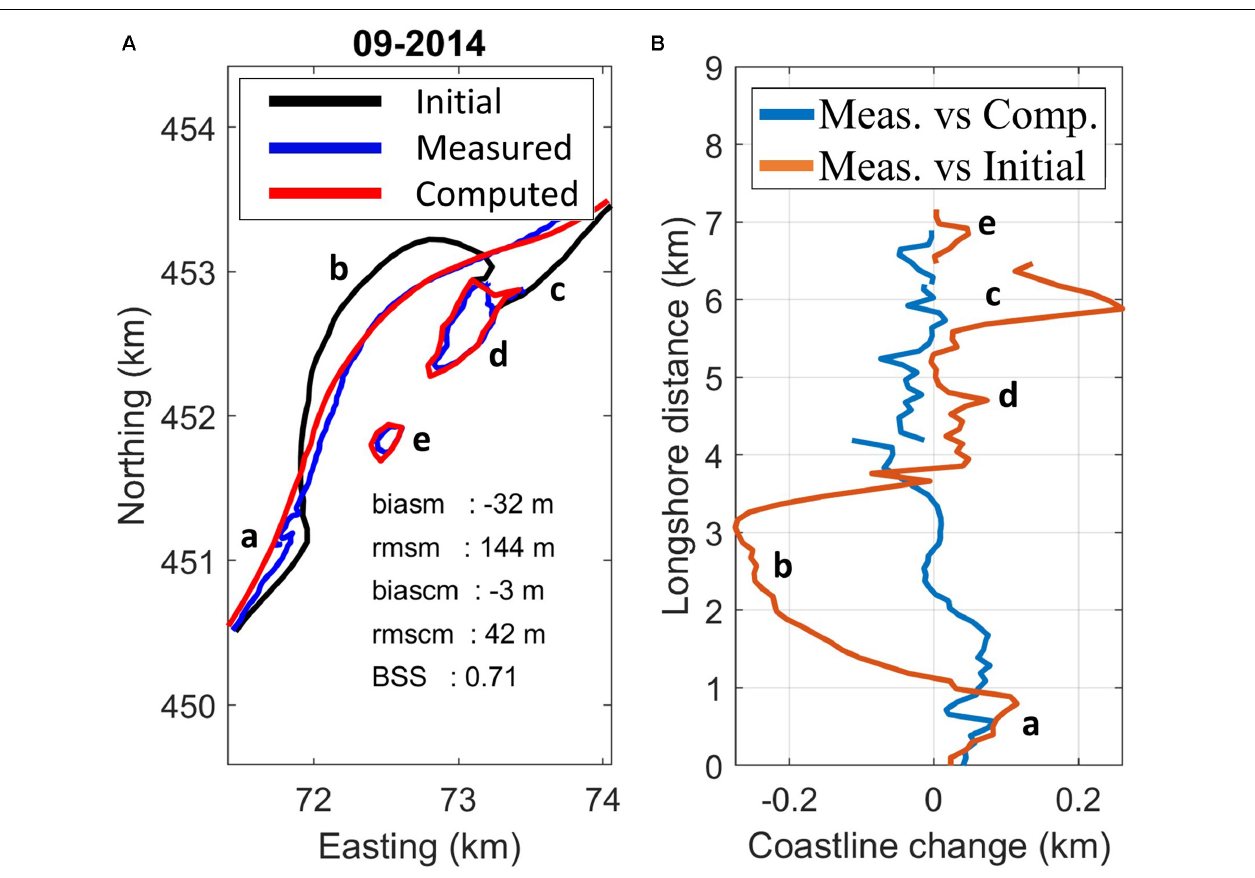
FIGURE 12 | Initial (2011), measured (meas.) and computed (comp.) coast lines after 3 years (A) ; coastline change vs alongshore distance: measured vs computed, and measured vs. initial (B) Letters in both panels indicate the corresponding